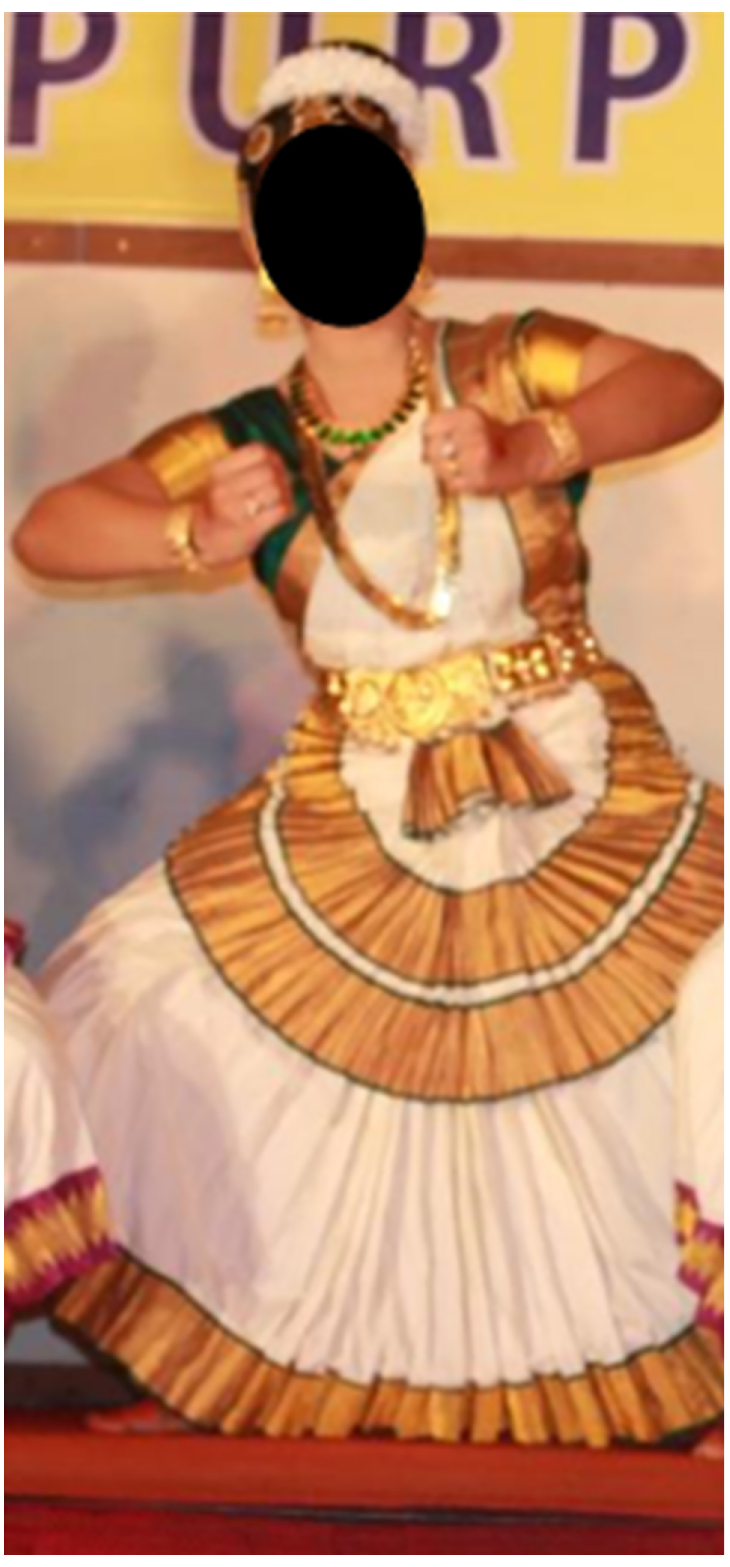
Fig 1. Dance is my passion—Mohiniyatam © G2, female, 15 years.